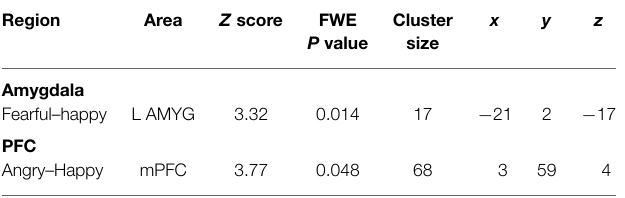
TABLE 2 | Small volume corrected coordinates, number of voxels, z score, and cluster level FWE-corrected P values for amygdala and mPFC in correlation with childhood income-to-need .